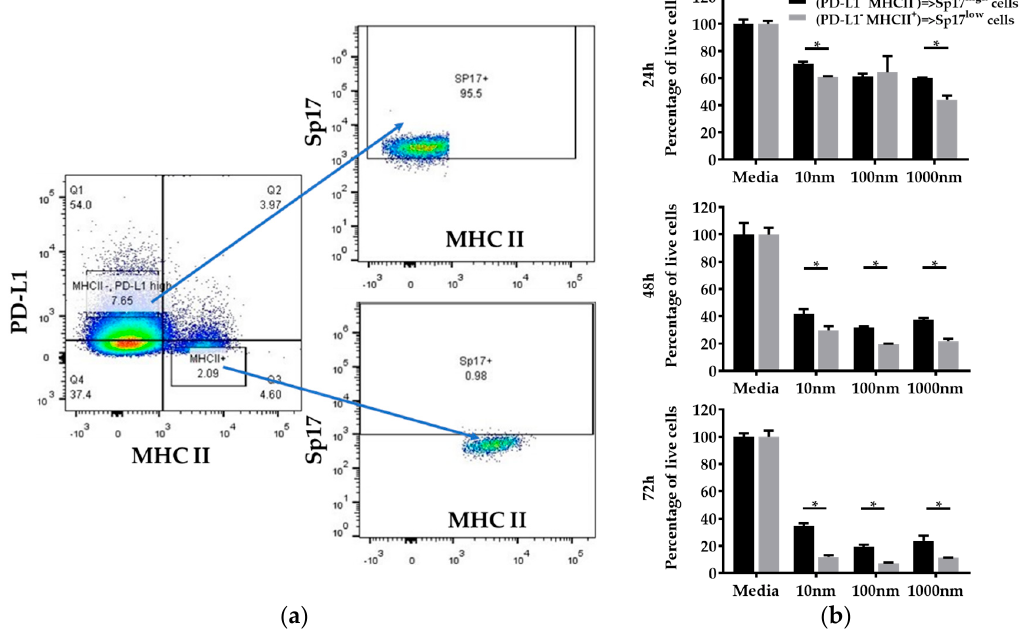
Figure 5. PD-L1 high MHCII − (Sp17 high ) population of ID8 cells are more Paclitaxel-resistant than PD-L1 − MHCII + (Sp17 low ) populations. ( a ) ID8 cells were FACS-sorted into two populations: PD-L1 high MHCII − and PD-L1 − MHCII + , based on cell surface staining with anti-PD-L1 and anti-MHC II antibodies, which represented the Sp17 high and Sp17 low cells. ( b ) MTT viability assay was used to assess the cytotoxicity of the two populations at multiple time points (24 h, 48 h, and 72 h) and doses (10–1000 nM). Data show the mean percentage of live cells from four samples with standard deviation for each condition. * p < 0.05 (unpaired, two-tailed Student’s t -test).